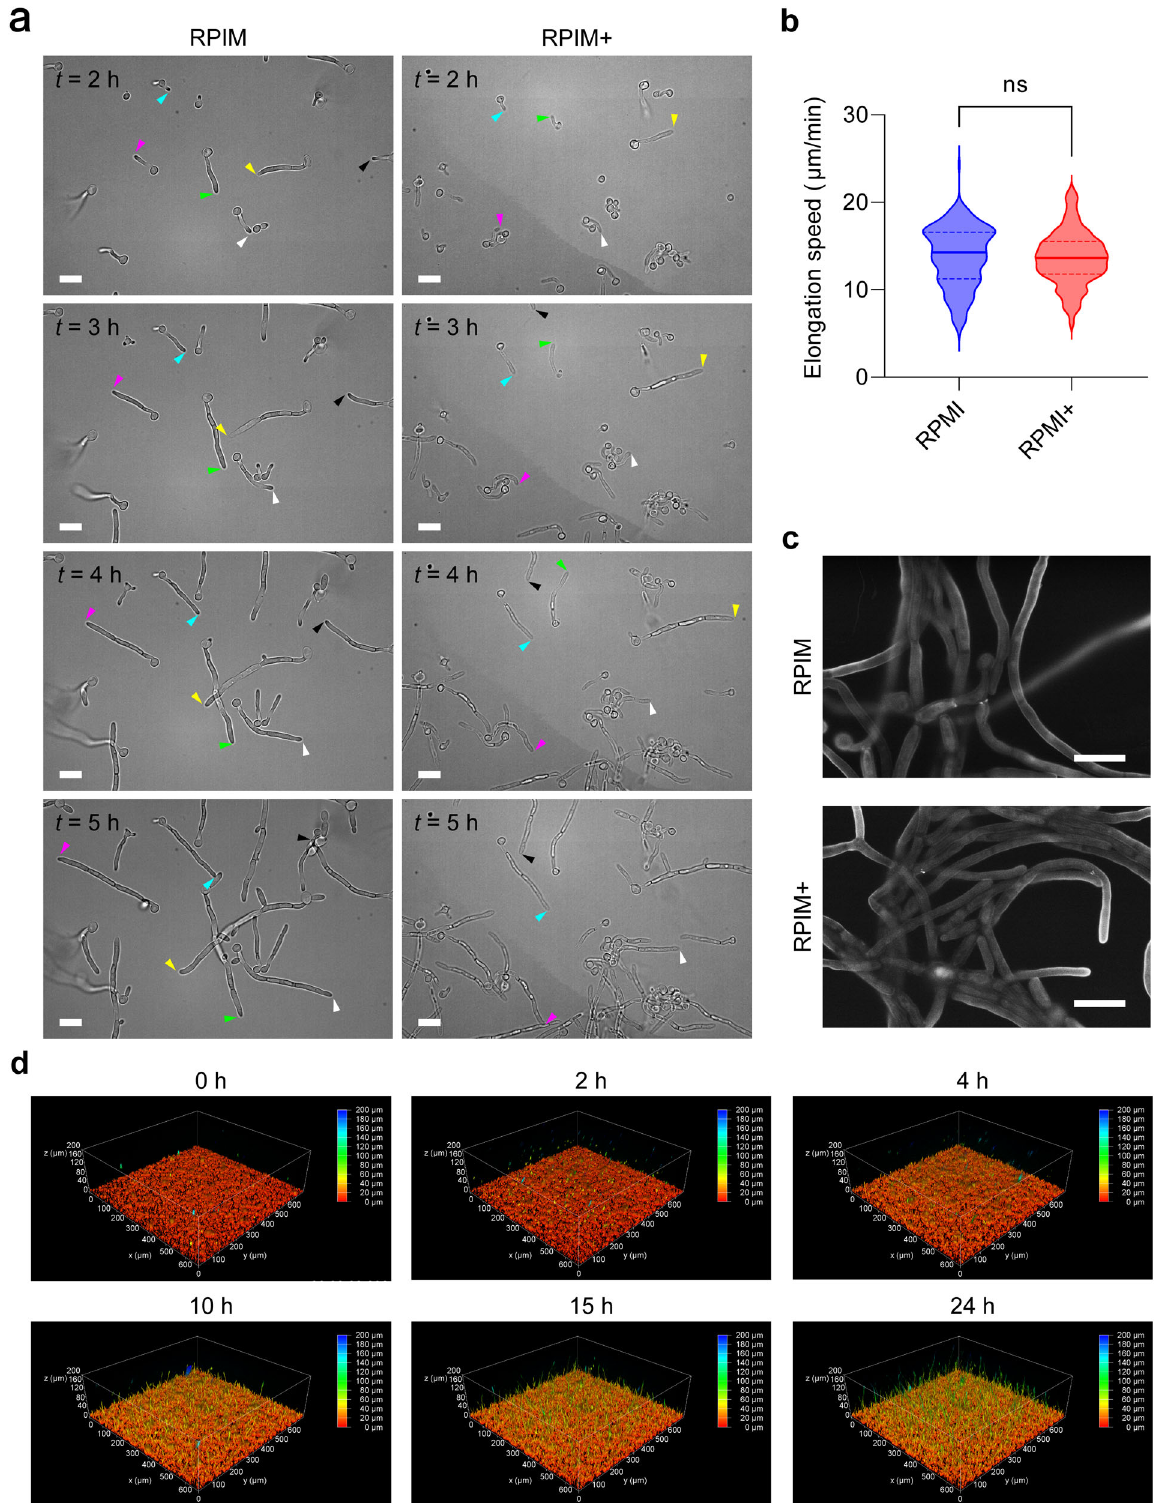
Fig. 8 Live-cell clearing imaging for bio fi lm formation of C. albicans . a Growth of C. albicans SC5314 cells on RPMI agar plates in the absence (RPMI) and presence of 30.0% (w/v) iodixanol (RPMI + ) were observed by phase-contrast microscopy. Colored arrowheads indicate individual elongating hyphae. b Violin plots of the elongation speeds of hyphae analyzed using microscopic images taken every 1 min. RPMI, n = 235. RPMI + , n = 185. ns, not signi fi cant (unpaired two-tailed Student t test). c ASEM images of SC5314 cells grown in RPMI and RPMI + liquid cultures. d The bio fi lm of SC5314 was formed in RPMI-MOPS (pH 7.0) containing 24% (w/v) iodixanol and 1- μ M MitoTracker Deep Red in a glass-bottomed dish. 3D images at the indicated time points are shown in a heat map color scale representing the thickness of the bio fi lm. Scales are 10 μ m in a , c